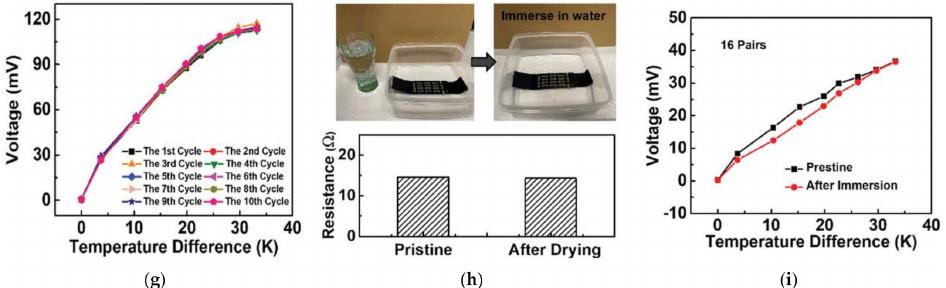
Figure 10. uf-TEGs’ performance: output voltage of different uf-TEGs (with 8, 16, and 48 pairs) for various ∆ T ( a ); output voltage vs. ∆ T, as a function of load resistance (between 10 and 70 Ω ), ( b ), and output voltage and power vs. electrical current ( c, d ) of the 48-pair uf-TEG. Comparison of the uf-TEG (48 pairs) output voltage and power with that provided by other fabric-based TEGs ( e, f ). uf-TEG cyclic heating tests (48 pairs) ( g ). immersion test of an 8-pair uf-TEG ( h ); the uf-TEG (16 pairs) output voltage vs. ∆ T before and after the immersion test ( i ) [88].